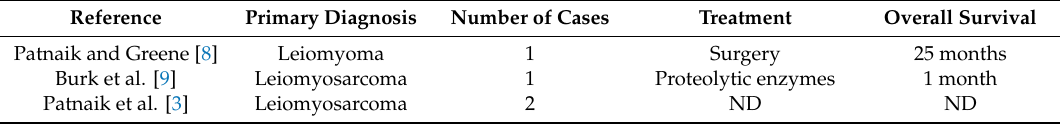
Table 2. Summary of the published cases involving primary bladder leiomyosarcoma in